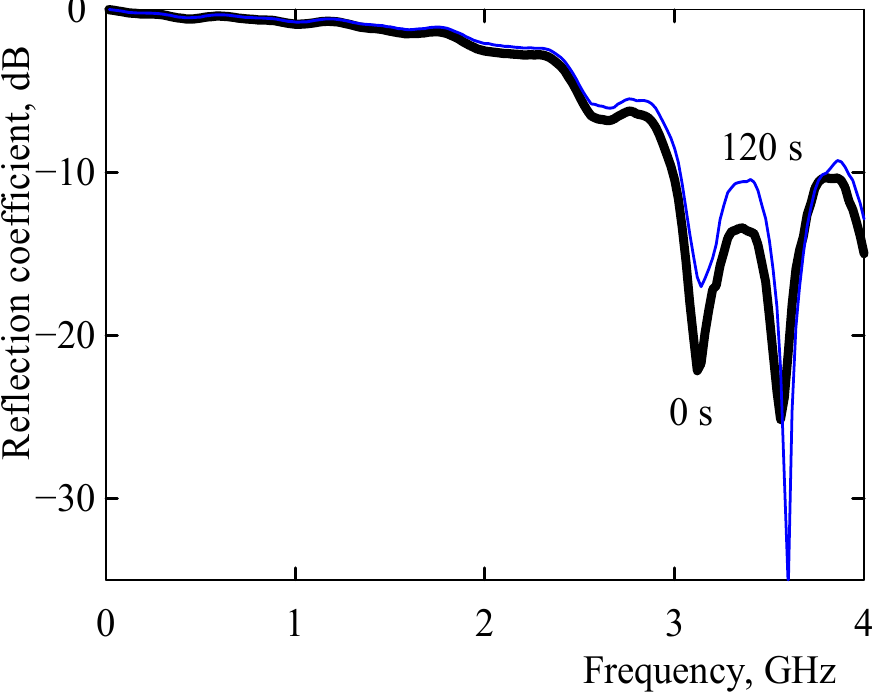
Figure 9. The reflection coefficient of the microstrip resonant sensor in the initial state prior to vapor exposure (thick black line) and after an exposure to non-polar heptane for 120 s at room temperature (thin blue line) within the indicated frequency range.